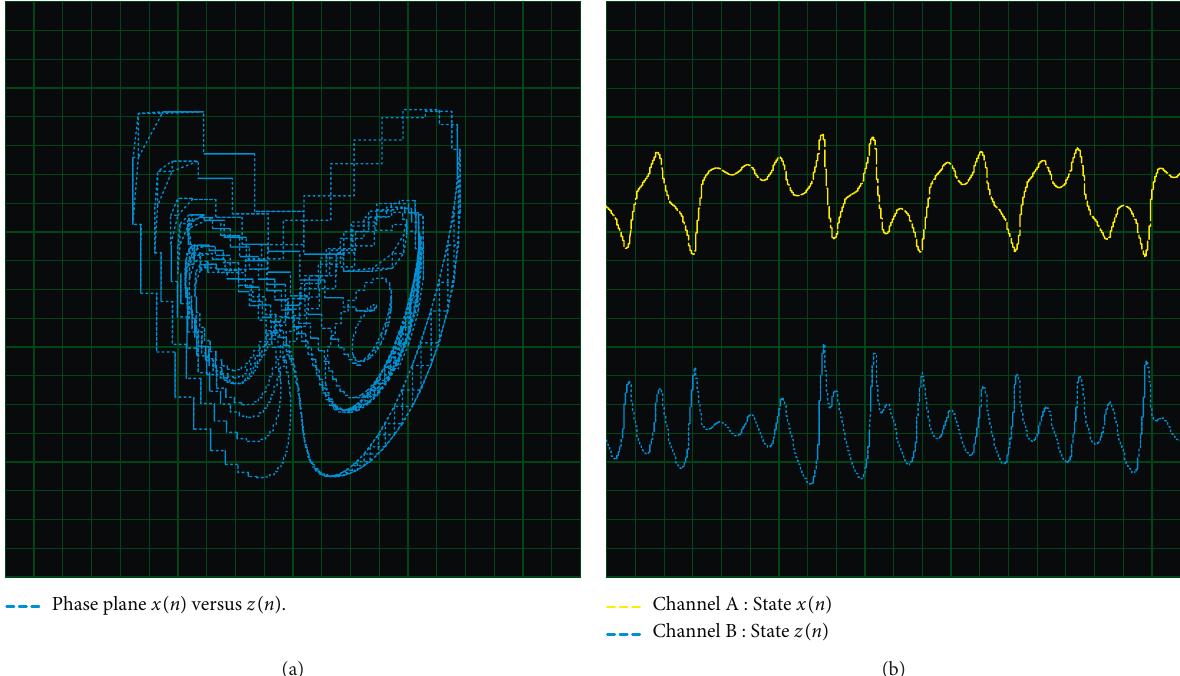
Figure 7: Simulation of ES in the V1 of Lorenz system in its DV by using τ state variables x ( n ) and z ( n ) .